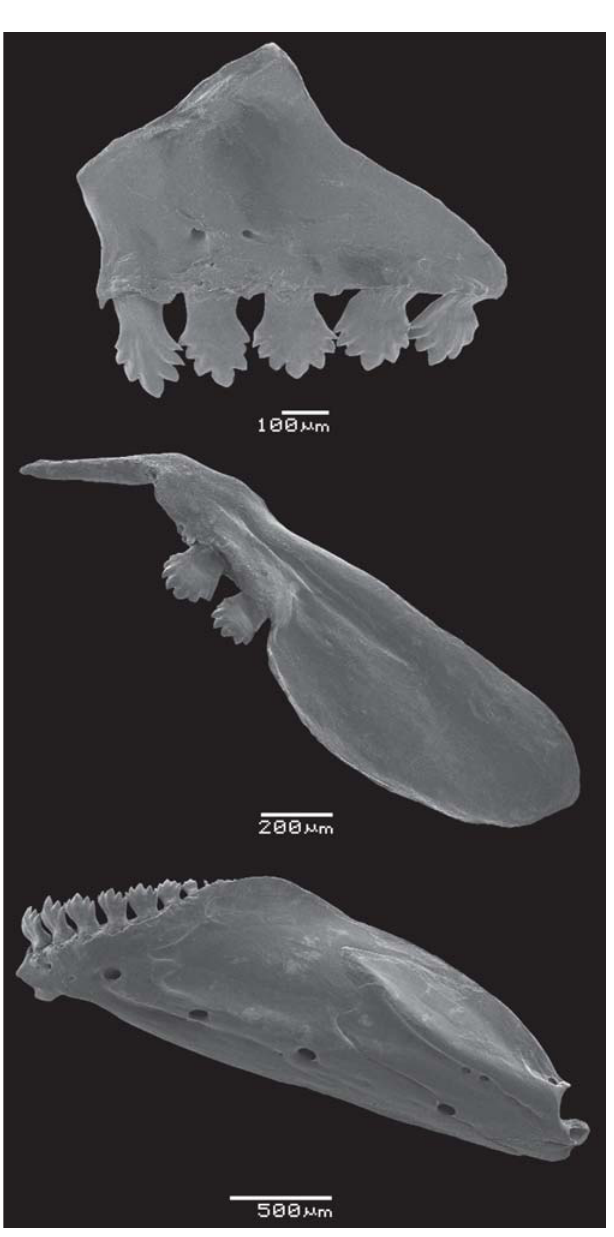
Fig 21. Dentition of Odontostilbe nareuda , FMNH 106433, male 31.6 mm SL. SEM photograph of left side premaxilla (top), maxilla (middle), and dentary (bottom).